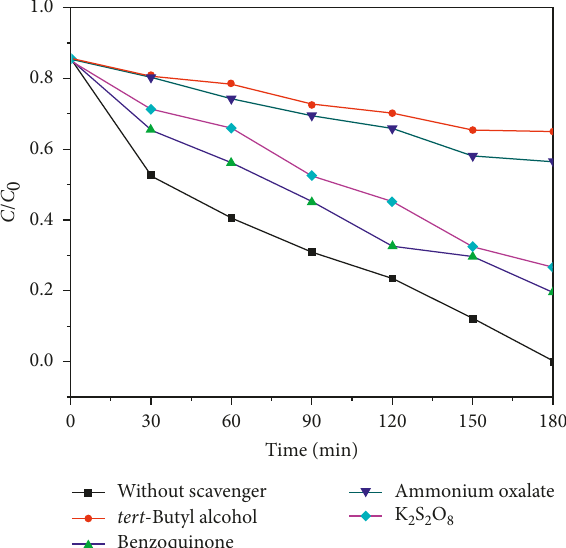
Figure 9: Evaluation of reactive radical species using various scavengers for photocatalytic degradation of MB by using